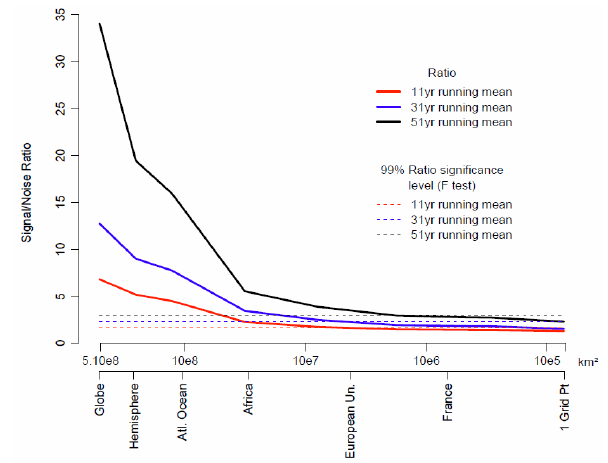
Figure 5 : Signal-Noise Ratio (SNR) calculated as a function of the spatial scale with the ratio of variance between the temperature in SGI and the CTRL described in Sec. 4. On the upper x-axis is the extent of the surface associated with the SNR. The lower x-axis gives references of geographic dimensions. The black, blue and red lines represent the SNR calculated with temperature time series smoothed with a 51, 31 and 11yr-running mean respectively. The black, blue and red dashed lines represent the 99 th quantile of the Fisher distribution with 17, 28 and 85 degrees of freedom (dof) equivalent to the number of dof of a 850-year long time series smoothed with 51, 31 and 11yr-running mean respectively.